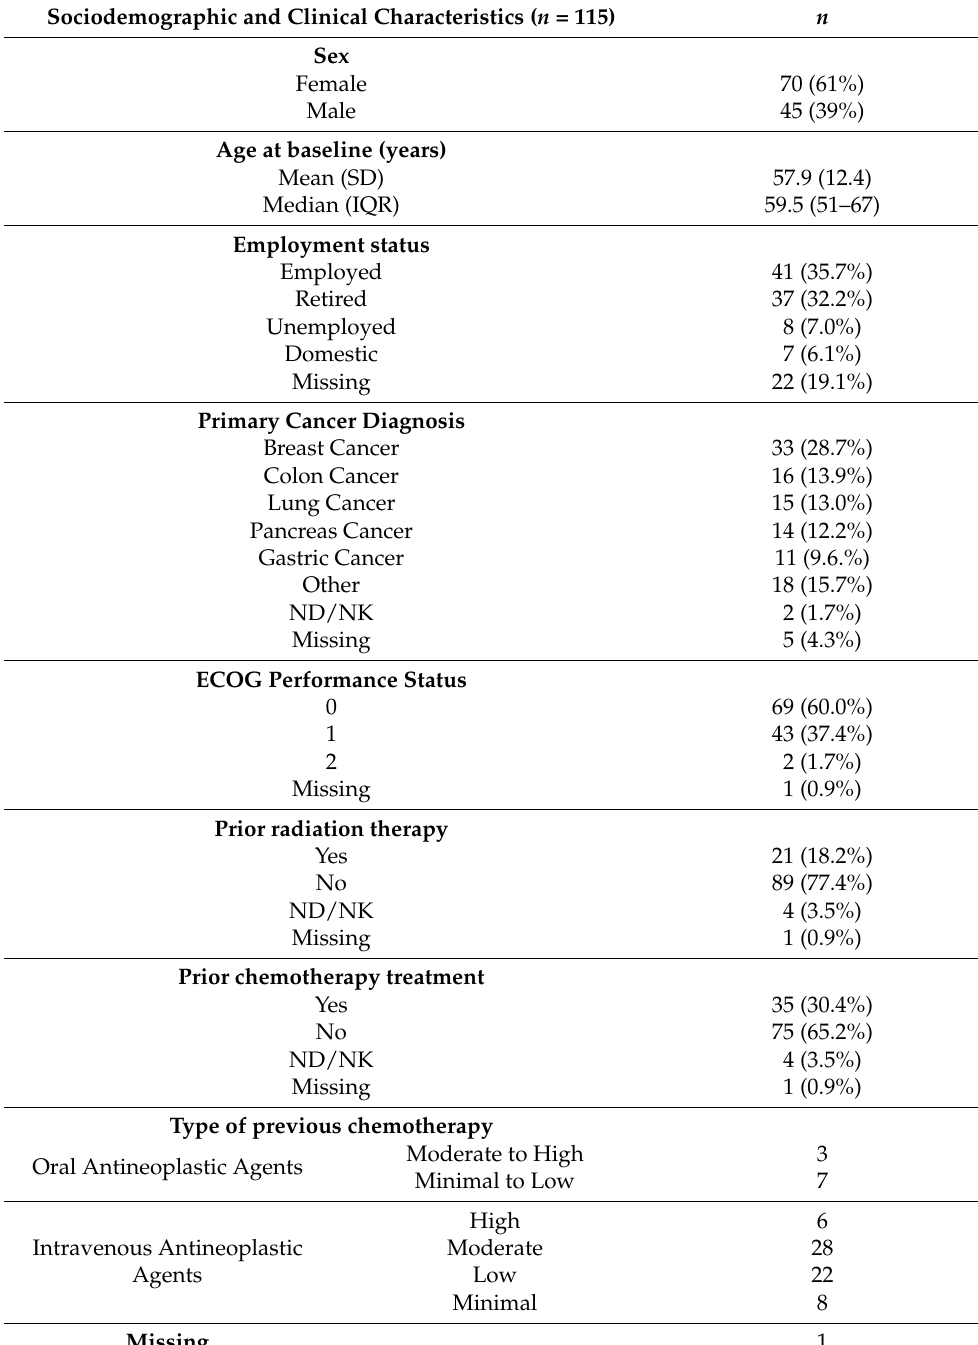
Table 1. Demographic and clinical characterisation of the